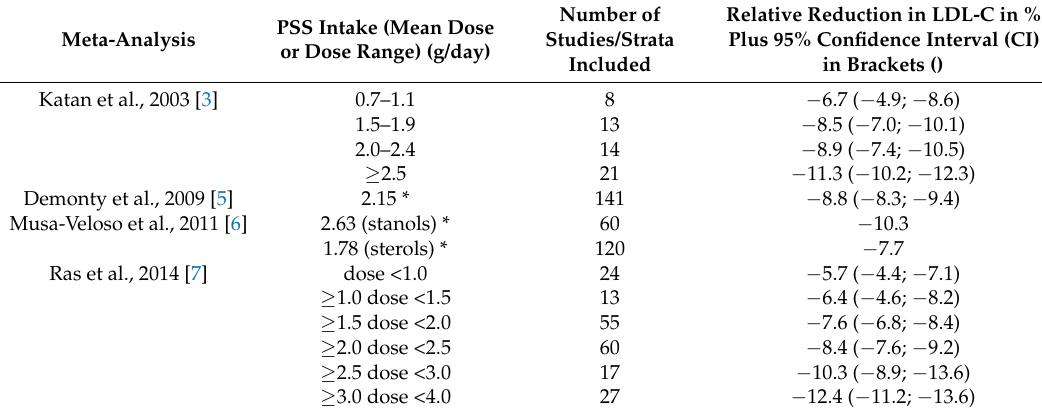
Table 1. Summary of the percent (%) LDL-cholesterol lowering effect of plant sterols and stanols (PSS) as described in